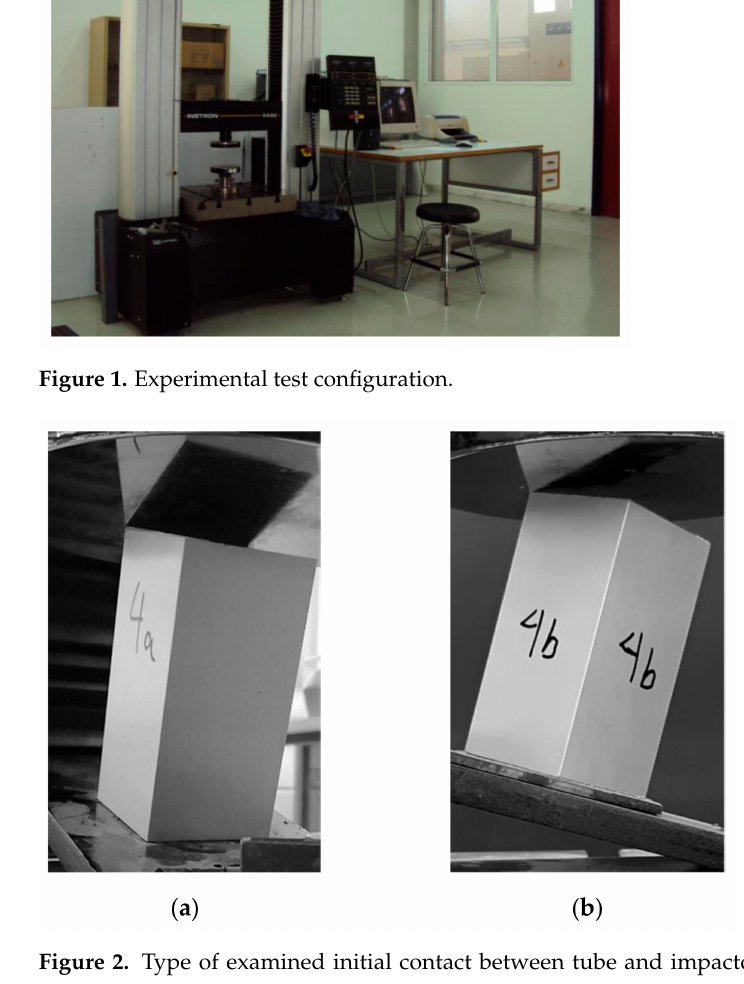
Figure 2. Type of examined initial contact between tube and impactor. ( a ) contact-in-edge case; ( b ) contact-in-corner